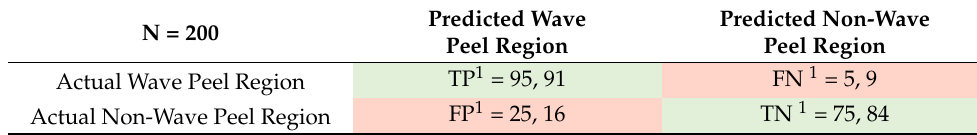
Table A1. CNN classifier confusion